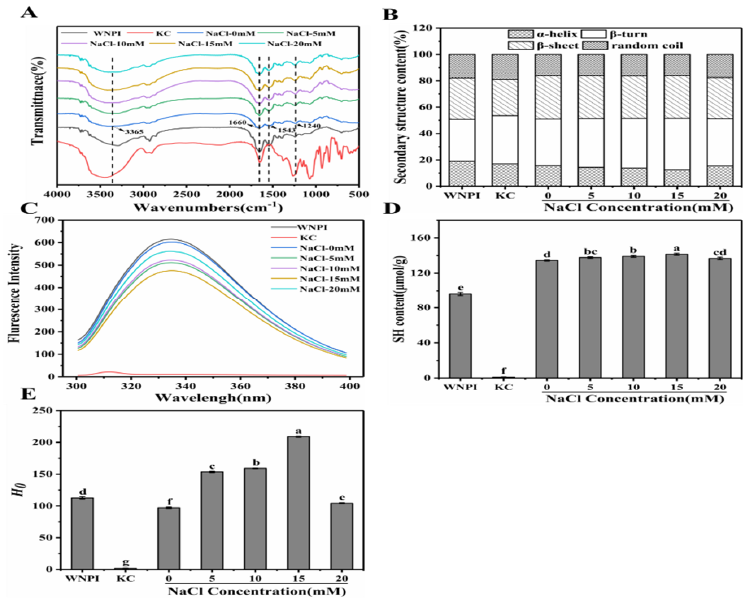
Figure 5. FTIR ( A ) structural content; ( B ) intrinsic fluorescence; ( C ) SH groups; ( D ) surface hydro- phobicity; ( E ) WNPI-KC composite gel samples with NaCl. Different letters on the bars indicate significant differences ( p < 0.05).